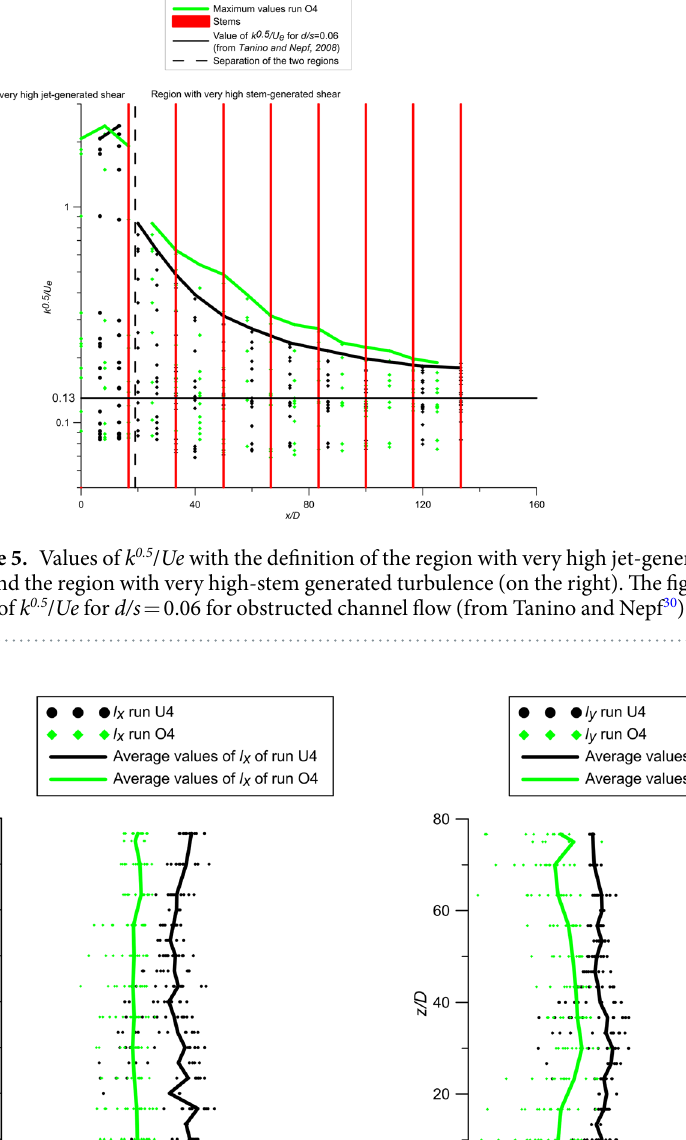
transverse diffusivity ( K yy ≈ 10 − 4 m 2 s − 1 ) The observed trends are totally different when the jet flows within the cylinder array (O4). First, in the obstructed condition the streamwise and transverse diffusivity have the same magnitude ( K in comparison to the unobstructed condition. In contrast, the transverse turbulent diffusion coefficient K yy is enhanced by the array obstruction (O4), relative to the jet without obstruction (U4), confirming the theoretical results on the jet detrainment process briefly described in the theoretical framework of the present paper and deeply analyzed and demonstrated by Mossa and De Serio 31 . In fact, in the case of obstructed flows, jets expe- rience a detrainment process, with which the jet fluid enters the ambient fluid. This result is consistent with the increase of the transverse diffusion coefficient of run O4, shown in Fig. 7, which reveals a diffusion from the jet axis towards the ambient. Finally, the average of the experimental values of K yy ( = 2 × 10 − 4 m 2 s − 1 ) in the obstructed flow is in good agreement with the model developed in Tanino and Nepf 30 . Specifically, for solid vol- ume fraction φ = 0.00283 (present study), eq. 2.16 and 4.1 in Tanino and Nepf 30 predict K yy = 0.18 U e d = 1 × 10 −